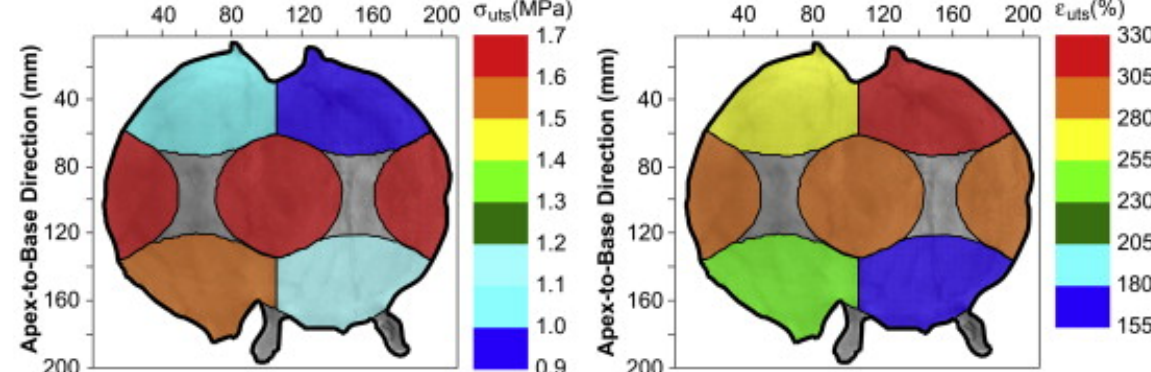
Figure 9. The figure illustrates the biomechanical parameters in different bladder regions. The graphs illustrate the ultimate tensile strength( σ uts ) and the highest failure strain( ɛ uts ) mean values obtained from different bladder regions corresponding to Figure 8b. Figure obtained with permission from [48].